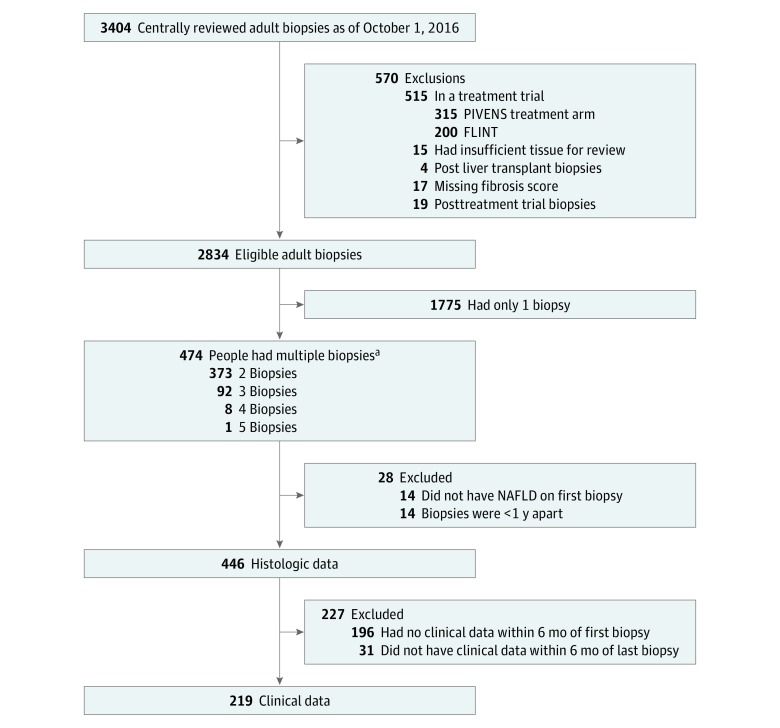
Flow Diagram Showing Participants Evaluated and Included in the StudyFLINT indicates the Farnesoid X Receptor Ligand Obeticholic Acid in NASH Treatment Trial; PIVENS, Pioglitazone versus Vitamin E versus Placebo for the Treatment of Nondiabetic Patients with Nonalcoholic Steatohepatitis Trial; and NAFLD, nonalcoholic fatty liver disease.aThe total number of biopsies was 1059.